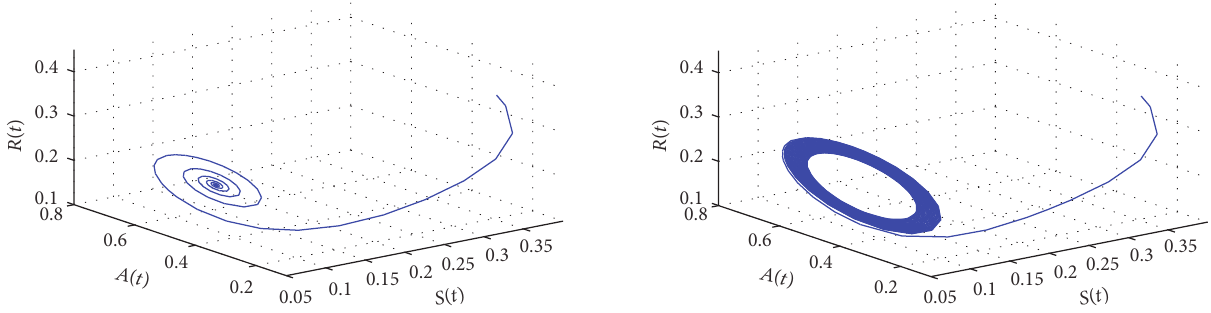
Figure 3: The phase plot of states 𝑆 ∗ , 𝐴 ∗ , and 𝑅 ∗ with 𝜏 1 = 29.49 > 28.4522 = 𝜏 10 .